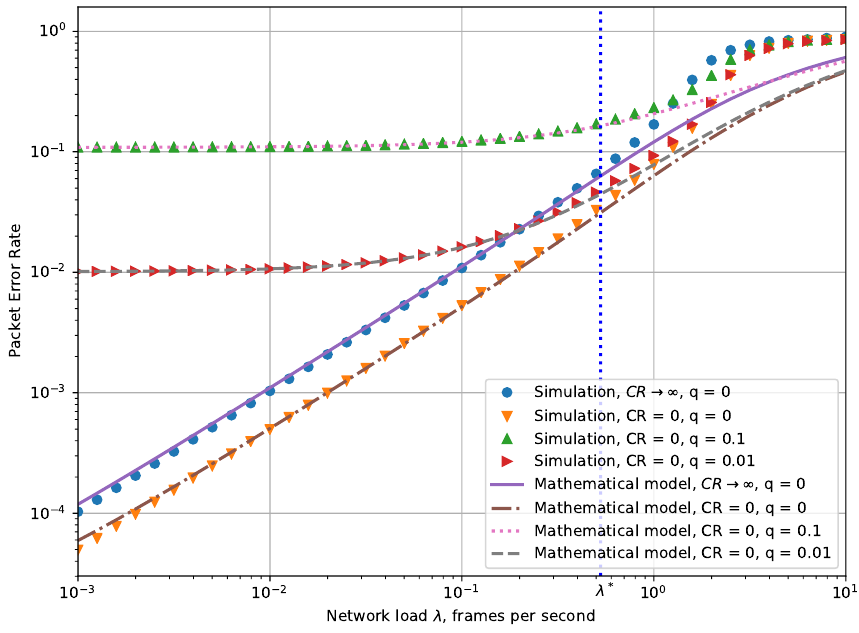
Figure 5. Dependency of packet error rate (PER) on the cumulative network